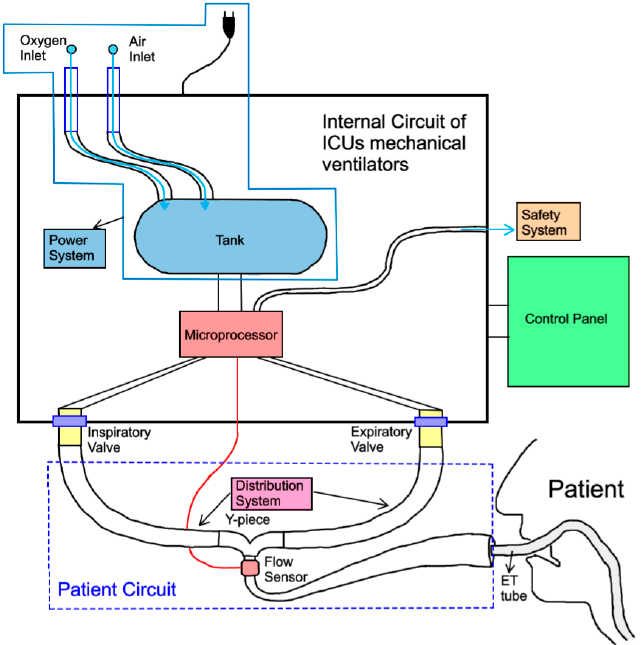
Figure 11. Key components of ICU mechanical ventilators.